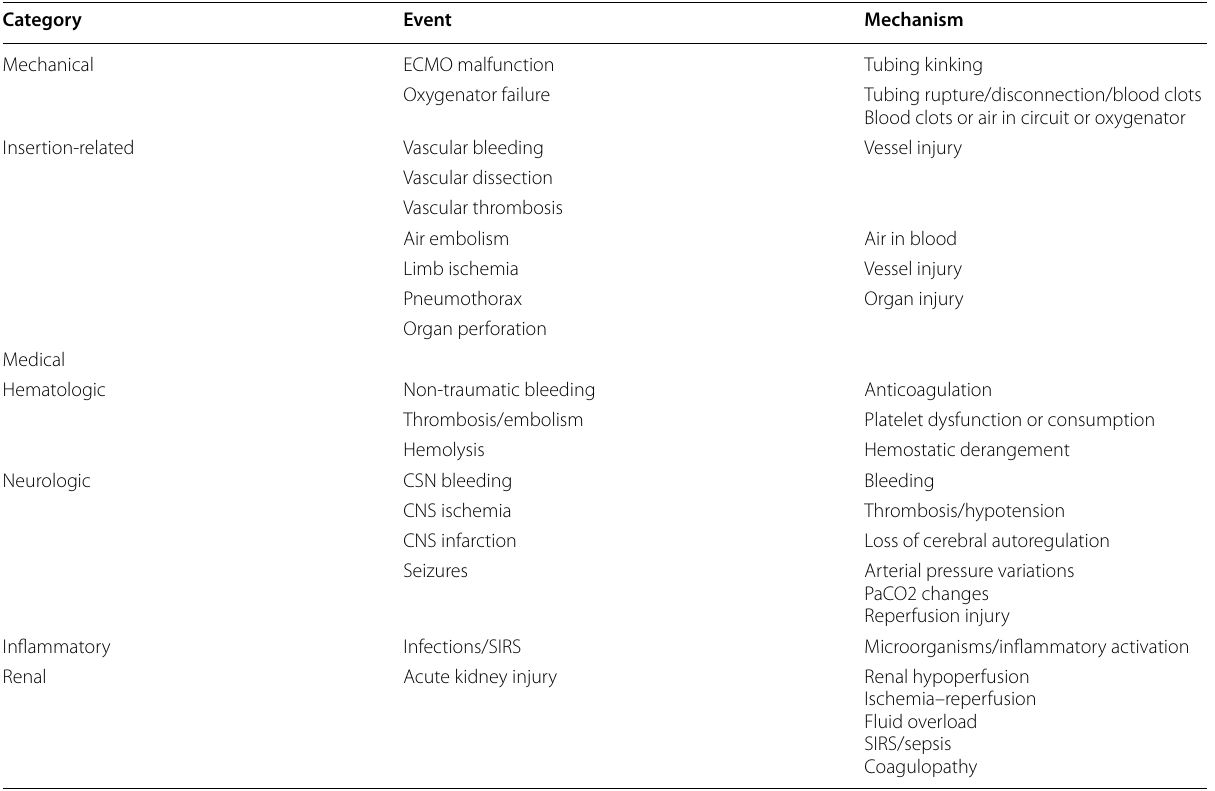
CNS, central nervous system; SIRS, systemic inflammatory response syndrome